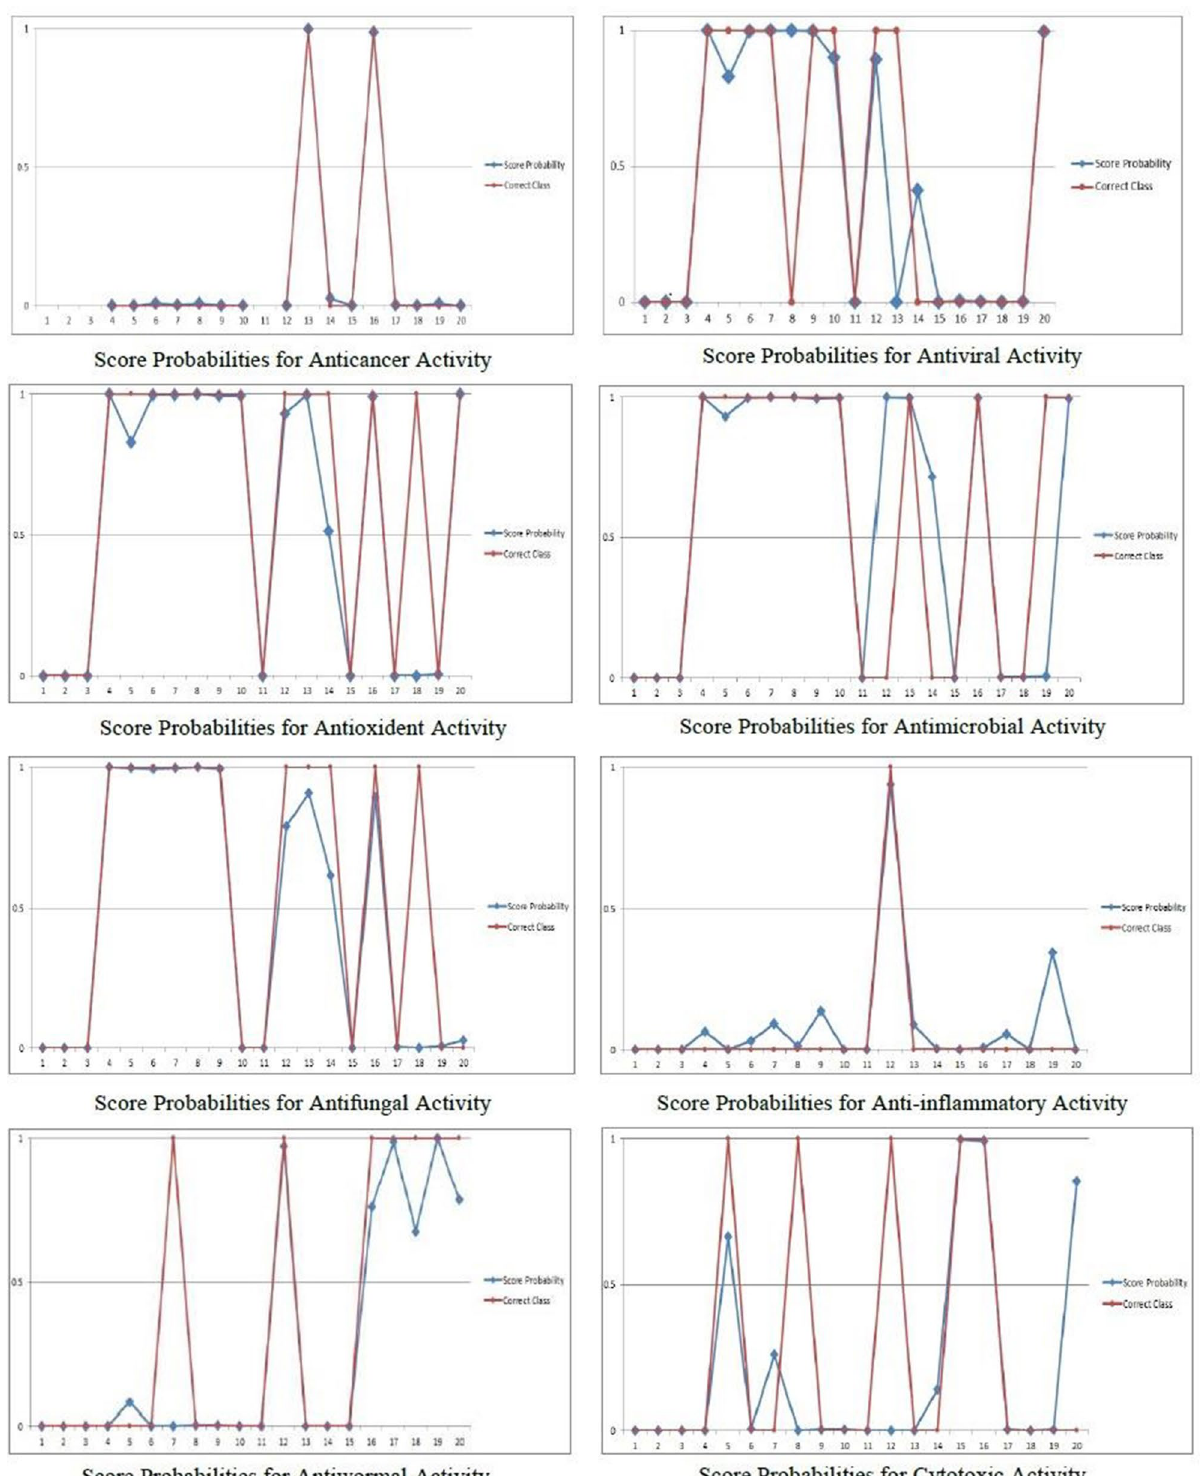
Figure 2. The discrimination outcome of the developed CNN for predicting the biological activities for a new essential oils’